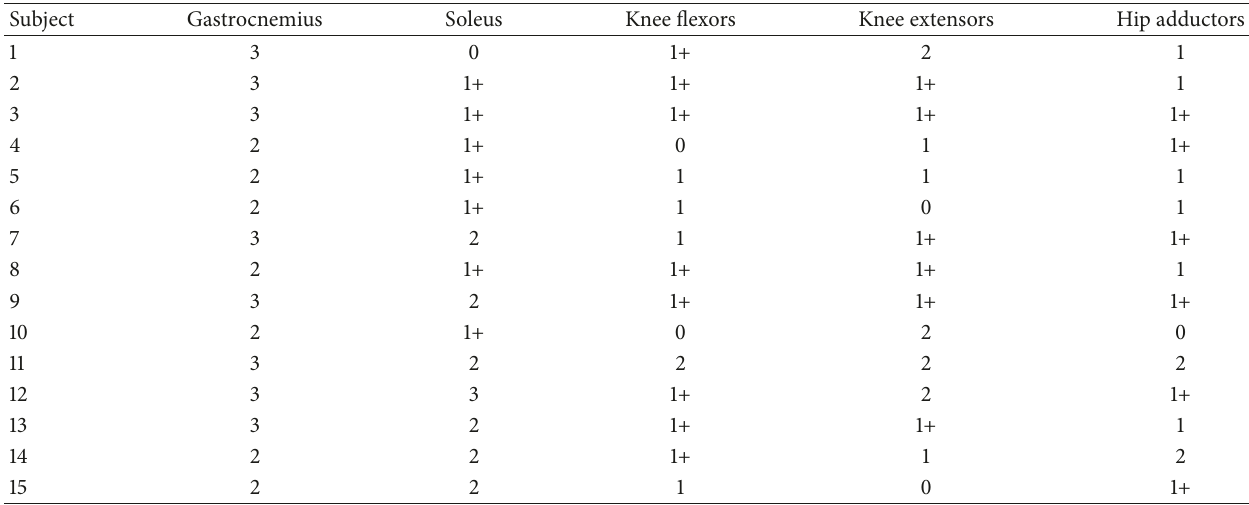
Table 2: Distribution of MAS scores in high spasticity